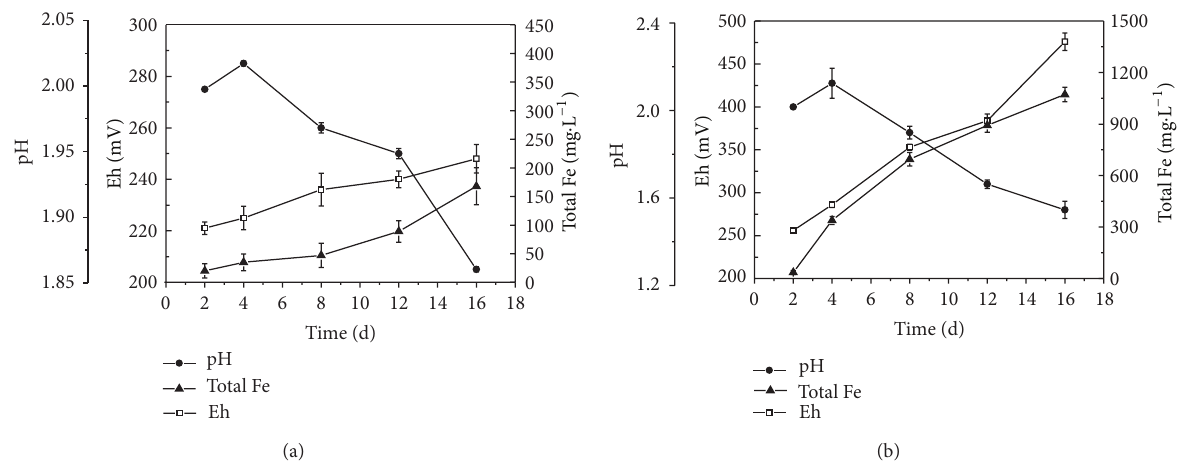
Figure 1: The biooxidation characteristics of coal without (a) and (b) with A.